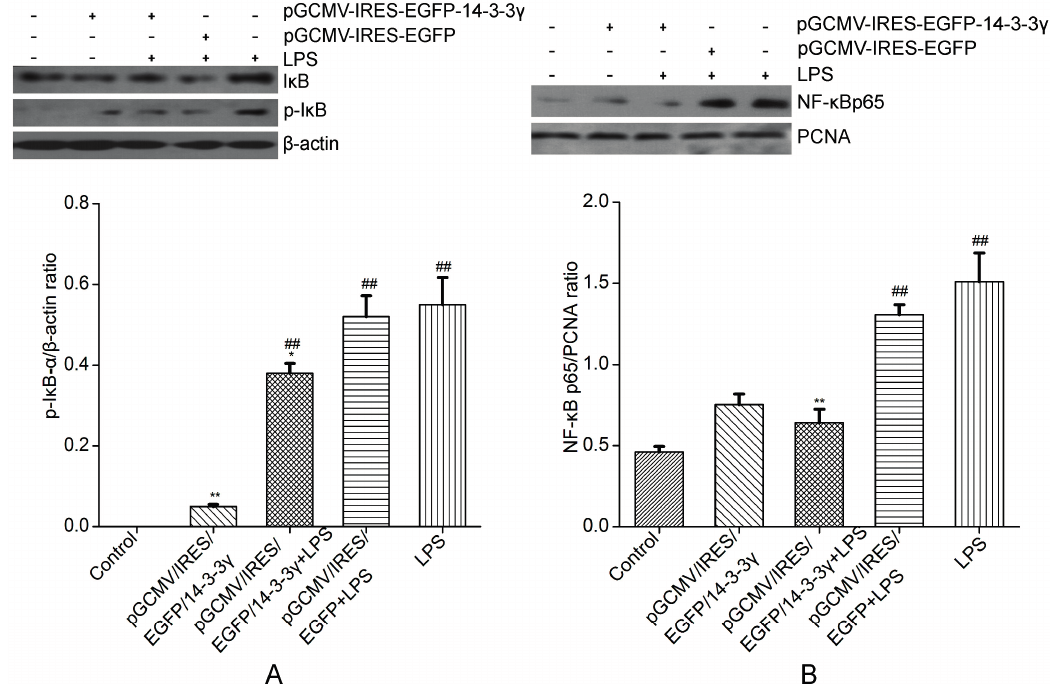
Figure 7. Effects of 14-3-3 γ overexpression on the nuclear factor- κ B (NF- κ B) signaling pathway in LPS-induced DCMECs. DCMECs were pre-transfected with pGCMV-IRES- EGFP-14-3-3 γ or pGCMV-IRES-EGFP. After 24 h, the cells were stimulated with LPS (1 μ g/mL) for 1 h. ( A ) Cytosolic proteins were analyzed by western blot for phosphorylated inhibitor inhibitor of NF- κ B (I κ B). β -Actin was used as a control; ( B ) Nuclear proteins were analyzed by western blot for nuclear factor- κ B p65 (NF- κ B p65). Proliferating cell nuclear antigen (PCNA) was used as a control. Bars indicate the mean ± SD ( n = 3). * p < 0.05 and ** p < 0.01 vs. LPS group; ## p < 0.01 vs. the control group. 2.8. 14-3-3 γ Overexpression Improved the Viability and Proliferation of LPS-Induced